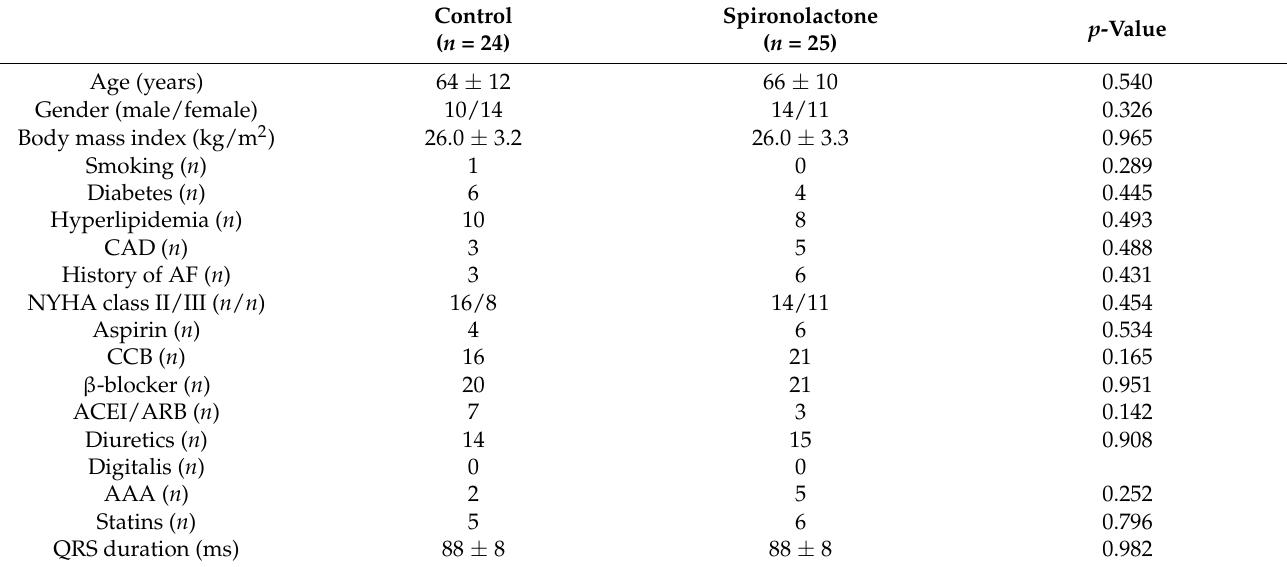
Table 1. Baseline clinical